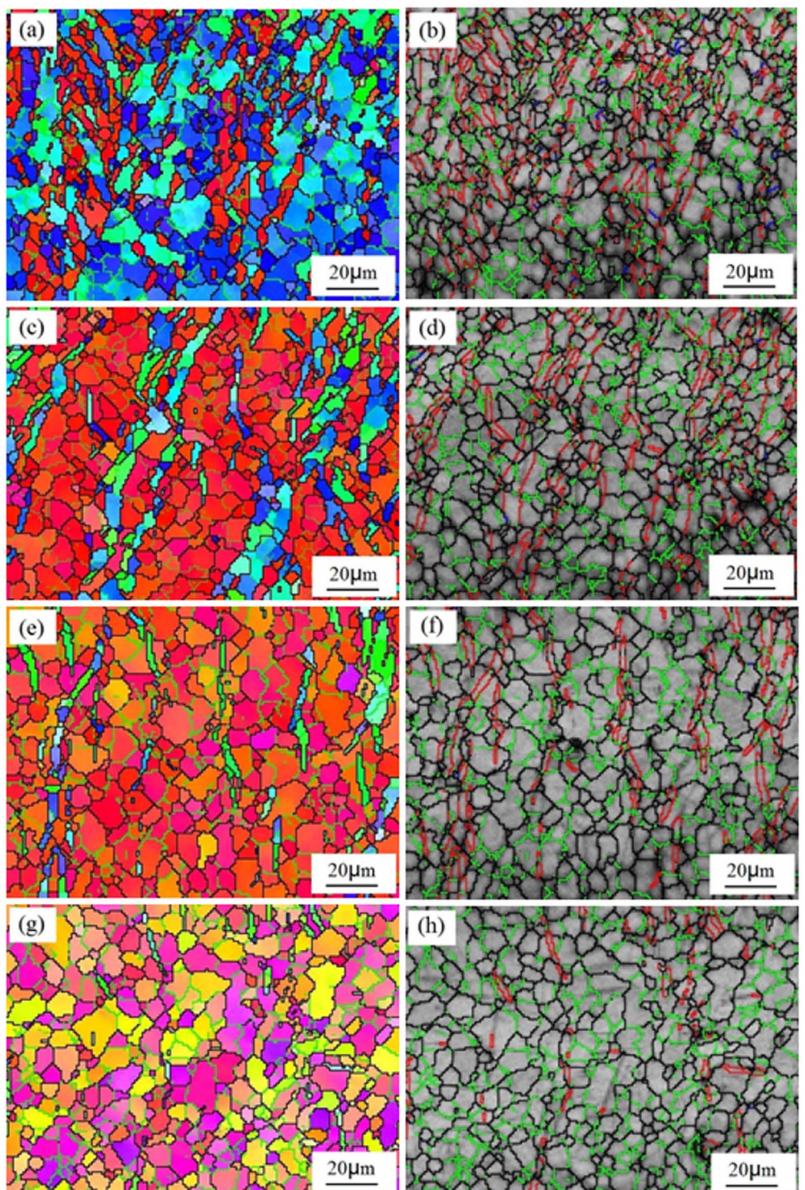
Figure 9. The electron back scatter di ff raction (EBSD) analysis from below to top in region 1 of FSW AZ31 joint after base bending ( a , c , e , g ) IPF maps ( b , d , f , h ) grain boundary maps. ~ 56 ◦ -blue, ~86 ◦ -red, 2–15 ◦ -green, > 15 ◦